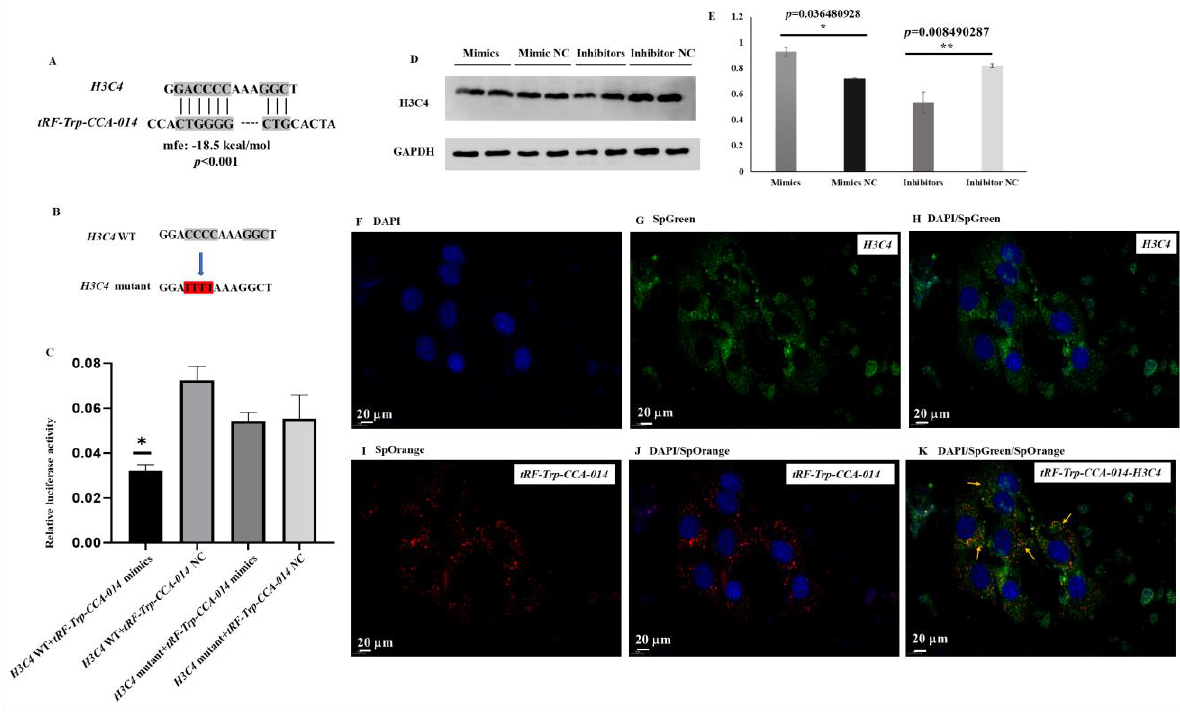
Figure 8. Analysis of the tRF-Trp-CCA-014 - H3C4 network in mouse NIH3T3 cells. ( A ) Binding sites between tRF-Trp-CCA-014 and H3C4 ; ( B ) mutant sites of the H3C4 3 ′ UTR; ( C ) binding properties of tRF-Trp-CCA-014 - H3C4 by dual luciferase reporter gene assay in 293T cells. ( D ) H3C4 protein expression level after transfection with tRF-Trp-CCA-014 mimics, negative control of tRF-Trp-CCA-014 mimics, tRF-Trp-CCA-014 inhibitors, and negative control of tRF-Trp-CCA-014 inhibitors in mouse NIH3T3 cells by Western blot. ( E ) quantification of protein bands in Figure 7D; ( F ) DAPI; ( G ) SpGreen for H3C4 ; ( H ) merged fluorescent images of ( F , H ); ( I ) SpOrange for Trp-CCA-014 ; ( J ) merged fluorescent images of ( F , I ); ( K ) merged fluorescent images of ( F , G , I ). NC—negative control; UTR—untranslated region; *, p < 0.05; **, p <